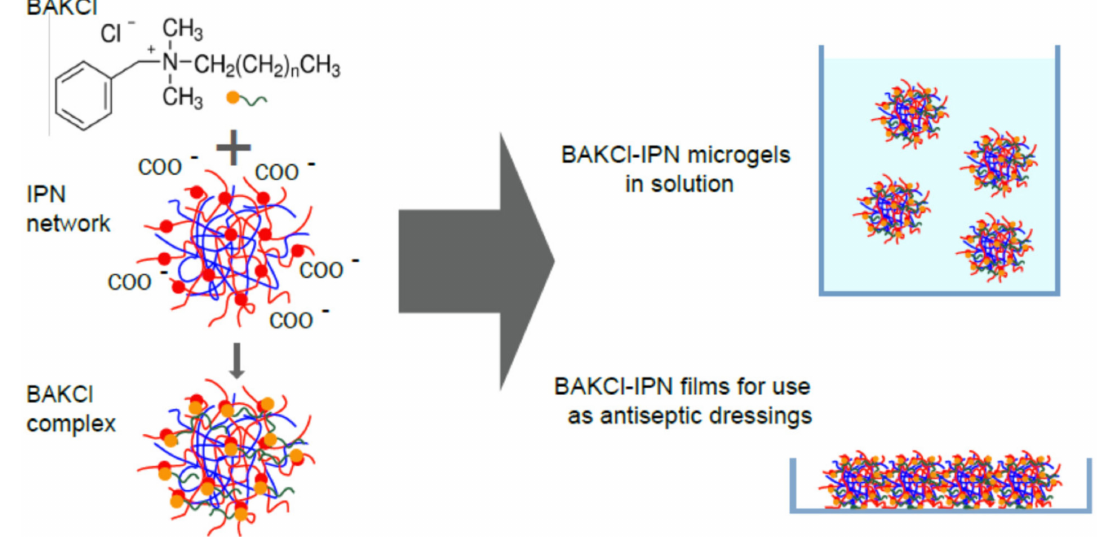
Figure 1. The scheme of the formation of BAKCl/IPN